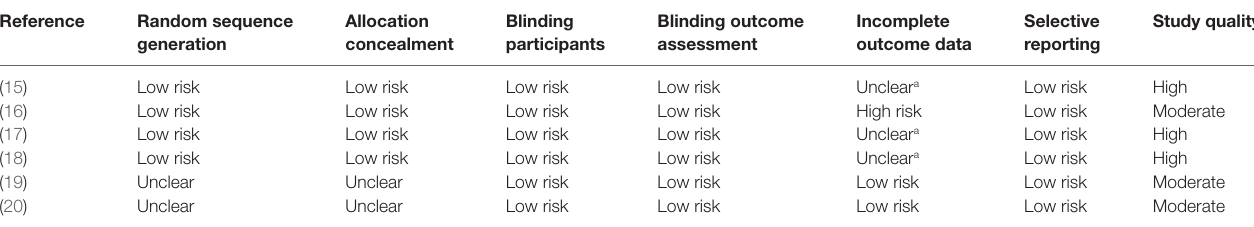
tABLe 2 | Risk of bias and quality of the RCT included in the systematic review.